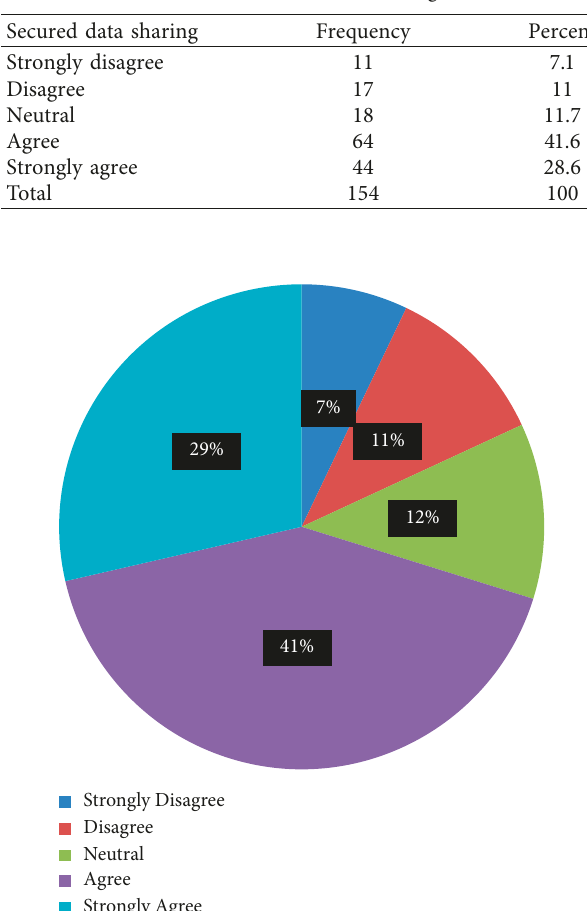
Figure 2: Secured data